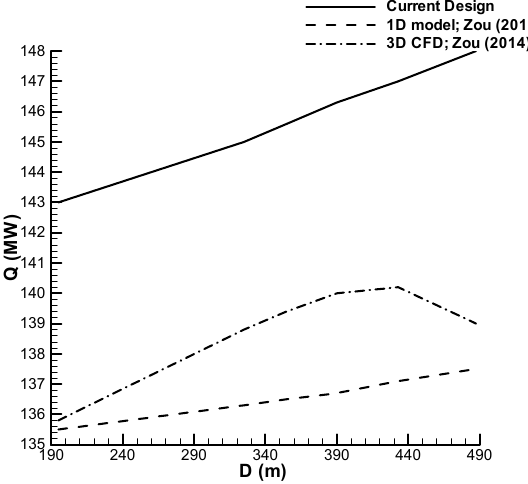
Figure 3. Heat transfer from the current design versus that of [5] for an identical tower size and height.